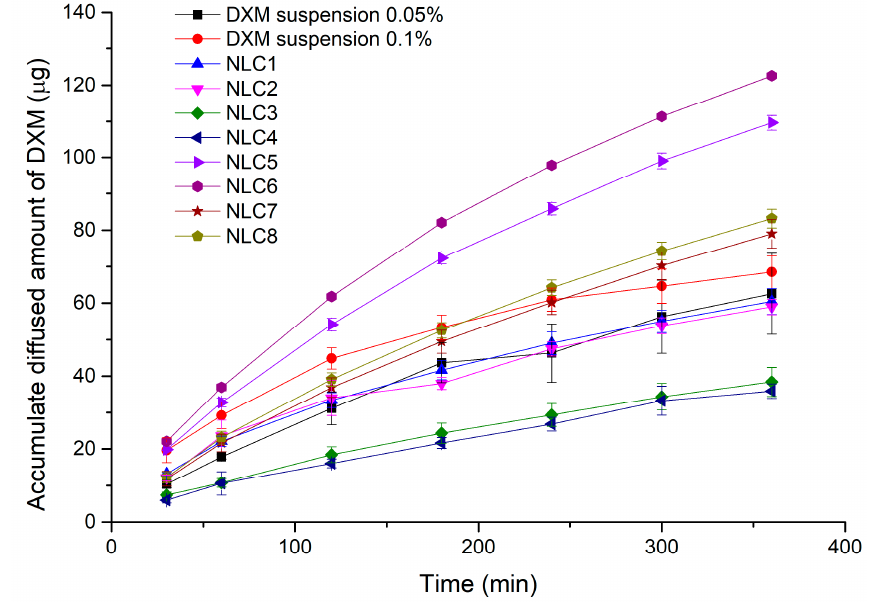
Figure 6. The di ff used amount of DXM from NLC compositions through dialysis Figure 6. The diffused amount of DXM from NLC compositions through dialysis membrane.